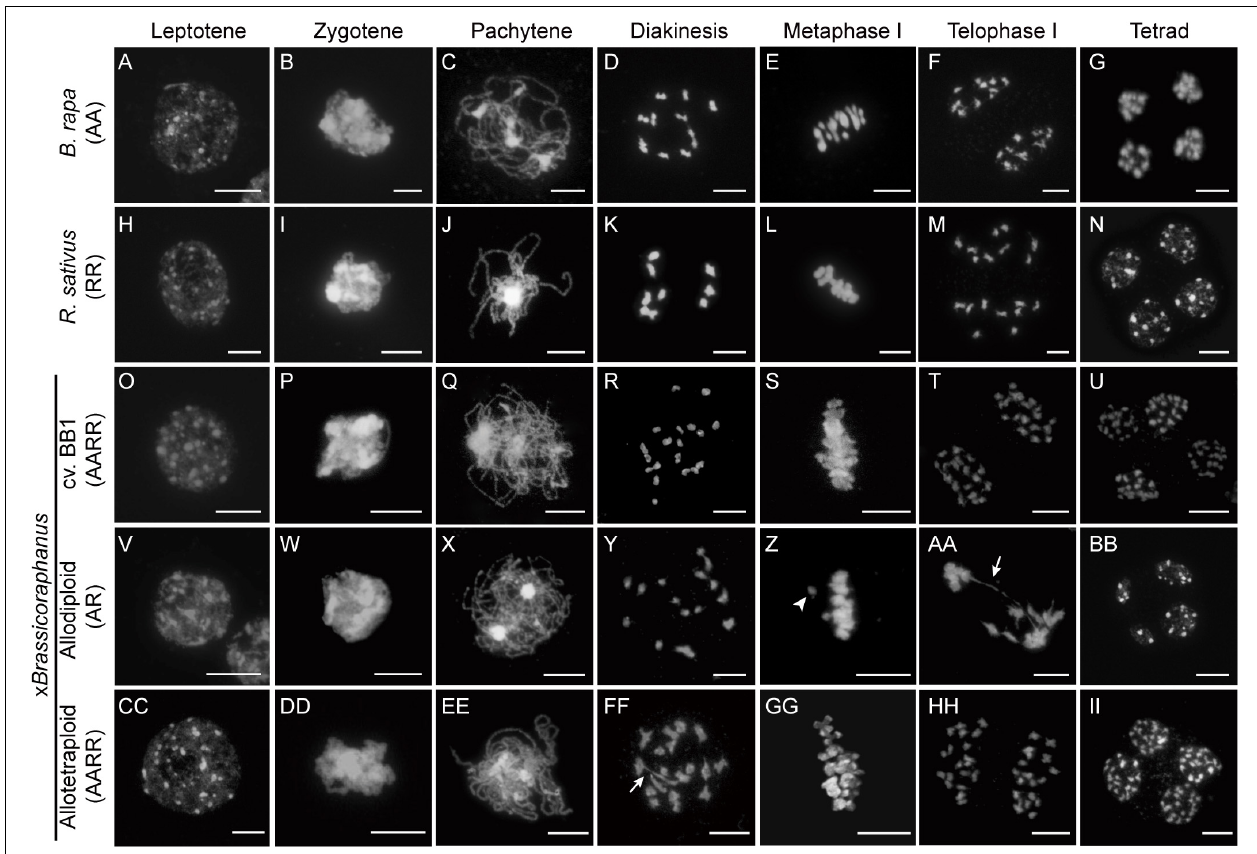
FIGURE 1 | Chromosome behavior during meiosis. The chromosomes in PMCs of B. rapa (A–G) , R. sativus (H–N) , BB1 (O–U) , and synthetic allodiploid (V–BB) and allotetraploid x Brassicoraphanus (CC–II) were visualized with DAPI staining. Meiotic chromosomes were condensed at leptotene (A,H,O,V,CC) , and seen as thin threads at zygotene (B,I,P,W,DD) . The synapsis between homologous chromosomes appeared at pachytene (C,J,Q,EE) . However, chromosomes were not juxtaposed and only thin chromosome threads were observed at pachytene of synthetic allodiploid x Brassicoraphanus (X) . Homologous chromosomes were condensed and bivalents were formed at diakinesis (D,K,R,FF) . Various numbers of univalents and multivalents were observed in synthetic allodiploid x Brassicoraphanus (Y) . All chromosomes were aligned on the metaphase plate at metaphase I (E,L,S,GG) but unpaired univalent (arrowhead) was sometimes detected in allodiploid x Brassicoraphanus (Z) . Homologous chromosomes were separated to the opposite poles at telophase I (F,M,T,AA,HH) . Chromosome bridges (arrow) were often observed in synthetic allodiploid x Brassicoraphanus (AA) . Individual chromatids were evenly separated into four microspores at tetrad (G,N,U,II) . Unbalanced tetrads were detected in allodiploid x Brassicoraphanus (BB) . Scale bars = 10 µ